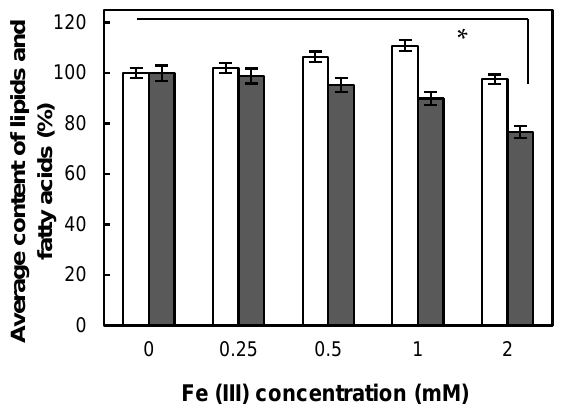
Figure 6. Effect of Fe (III) concentration on the average content between days 2 and 9 of lipids (empty bars) and fatty acids (grey bars) of the microalga C. onubensis . In total, 100% of average content of lipids and fatty acids corresponds to 31.52 and 12.63 mg · g − 1 biomass, expressed as percentage, respectively. (*) Represents the significant differences of all treatments with respect to the control with 95% confidence.